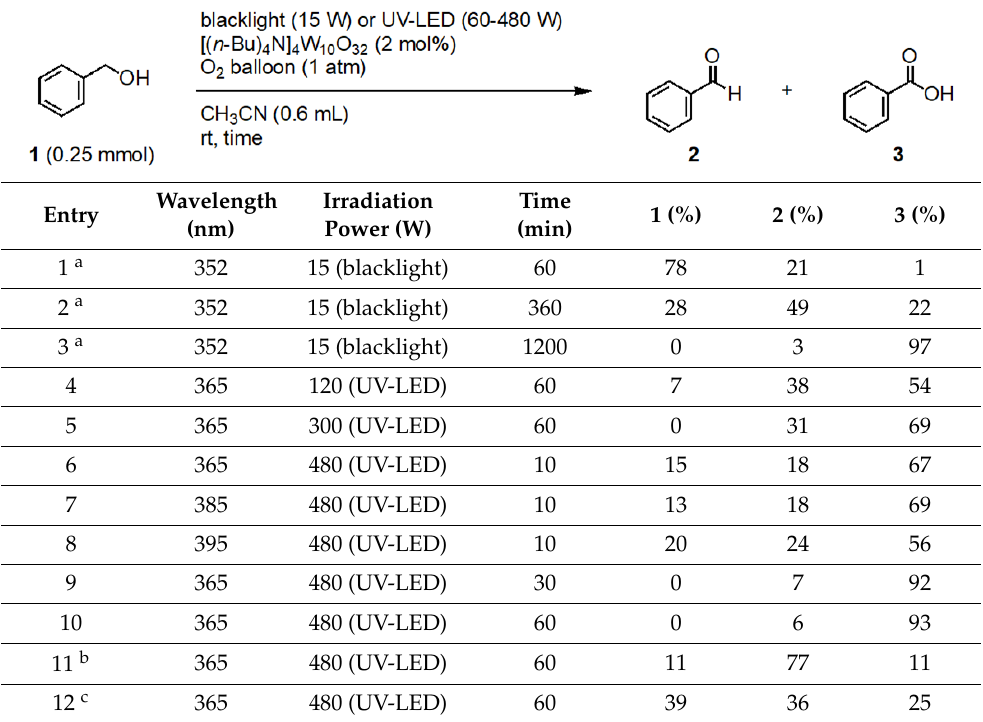
Table 1. Oxidation of benzyl alcohol 1 by molecular oxygen with a catalytic amount of TBADT under photo-irradiation.